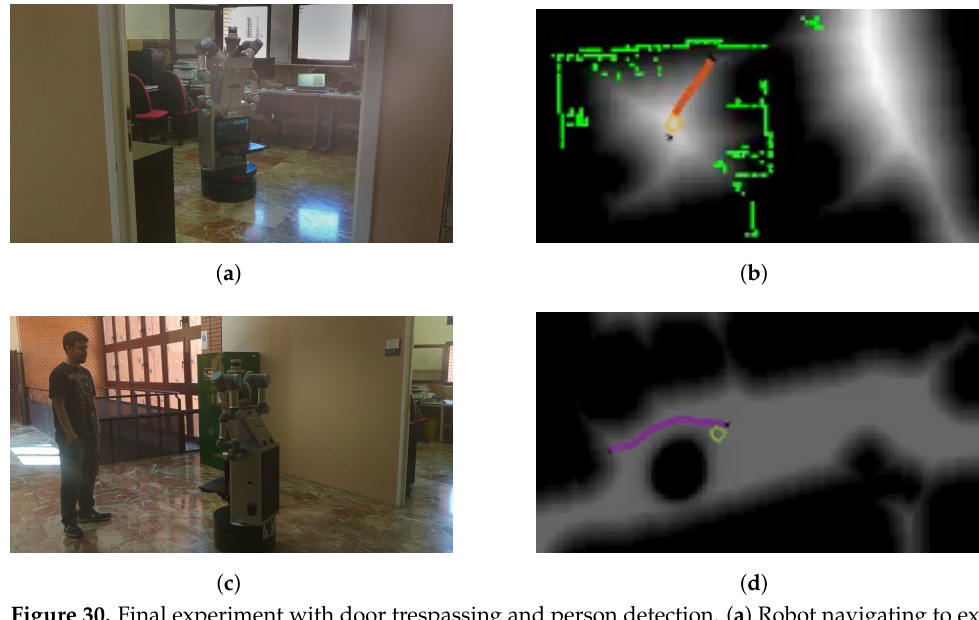
Figure 30. Final experiment with door trespassing and person detection. ( a ) Robot navigating to exit the room; ( b ) path (red) to move to the coordinate corresponding to the door topological node (green corresponds to LiDAR measurements); ( c ) detection of a person in front of the robot that stands in the path.; ( d ) path replanning considering the personal space of the detected